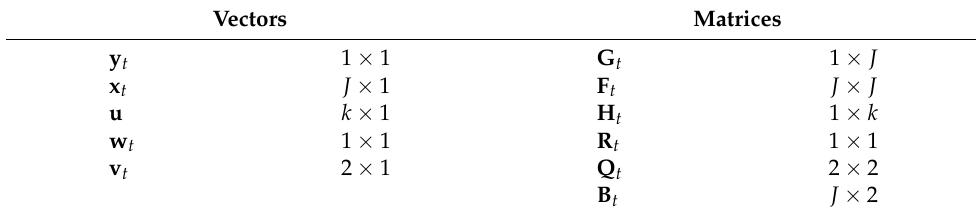
Table 7. Dimensions in the state space model of Atherino et al. (2010). Vectors Matrices y